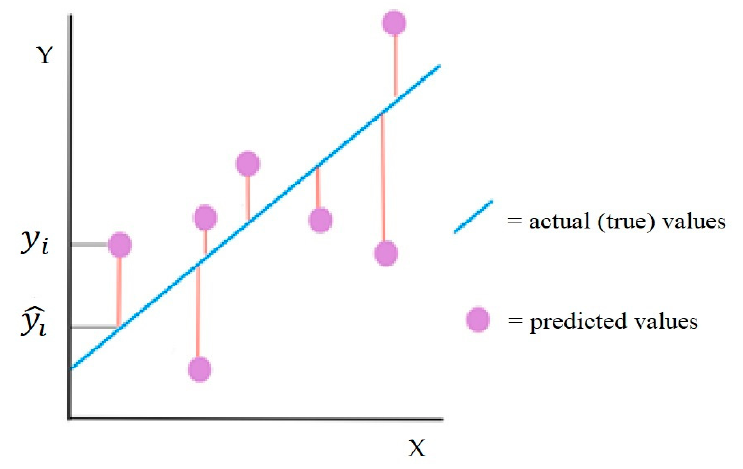
Figure 8. Prediction results of regression algorithm.